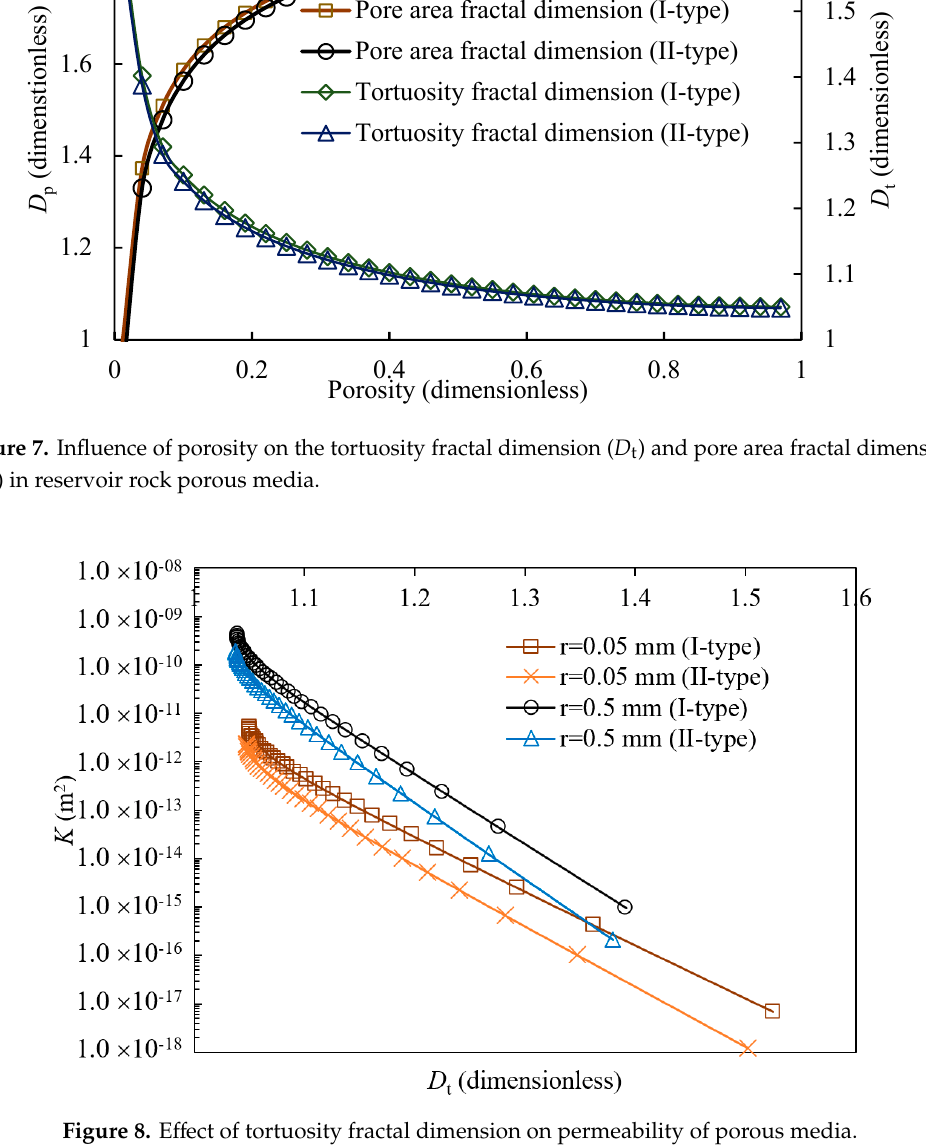
Figure 9. Effect of pore area fractal dimension on permeability of porous media. In order to analyze the influence of particle arrangement mode on permeability, the permeability difference coefficient R caused by different particle arrangement mode is introduced. The connotation of R is to reflect the influence degree of solid particle arrangement mode on permeability. The larger R value is, the greater the influence degree of permeability is by solid particle arrangement mode. R can be expressed as: